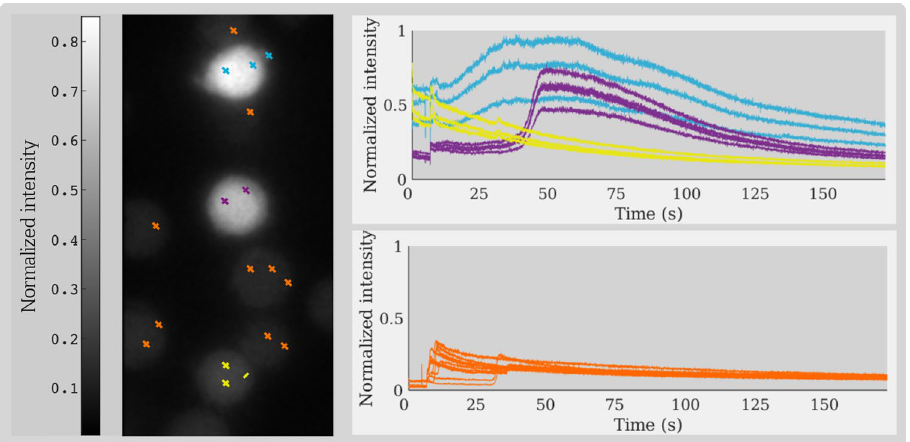
Figure 4. Examples of temporal signals recorded for Jurkat T-cell pixels (depicted in blue, purple and yellow) and antibody-coated beads (orange). The time-series highlight the notable difference in the fluorescence intensity levels obtained from different cells. Although the graphs recorded from sites corresponding to beads follow similar temporal patterns, there are lags between the times they appear in the imaging data. Near the end of the recording course, the fluorescence intensity at the bead sites are quite comparable to the cell intensities, making a frame-by-frame segmentation/classification ineffective [Graphics created with MATLAB and the Image Processing Toolbox Release 2019b, The MathWorks, Inc. (http:// mathw orks. com/ produ cts/ image.